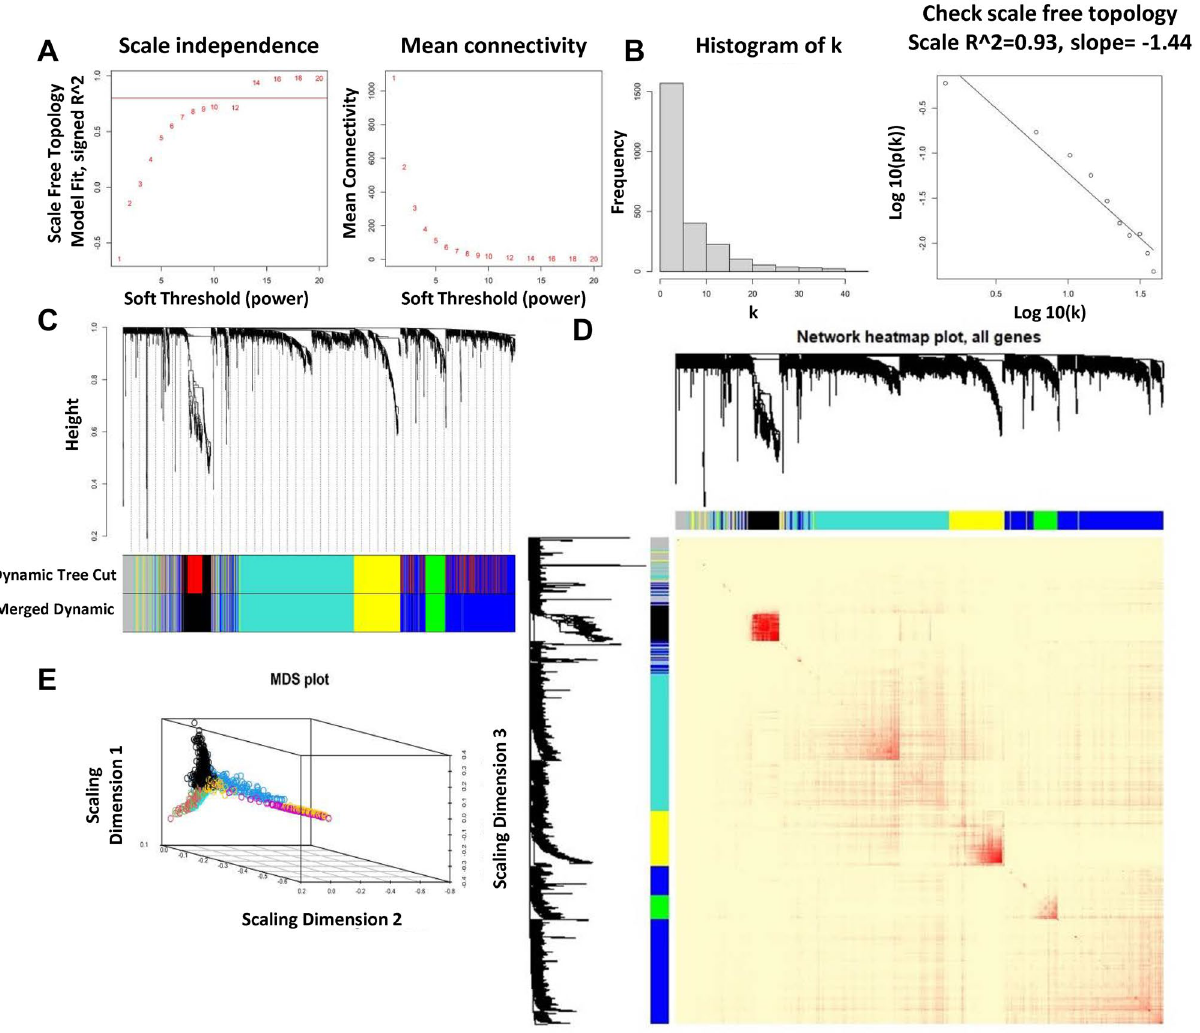
Figure 2. Network visualization plots. ( A ) Scale independence and mean connectivity analysis. The proper soft threshold power = 14 was selected. ( B ) The histogram of connectivity distribution and the scale-free topology panels. ( C ) Clustering dendrogram of genes, with dissimilarity based on the topological overlap. ( D ) Heatmap plot to represent the TOM among the genes in different modules. ( E ) Multidimensional scaling (MDS) plots to describe the entire gene expression